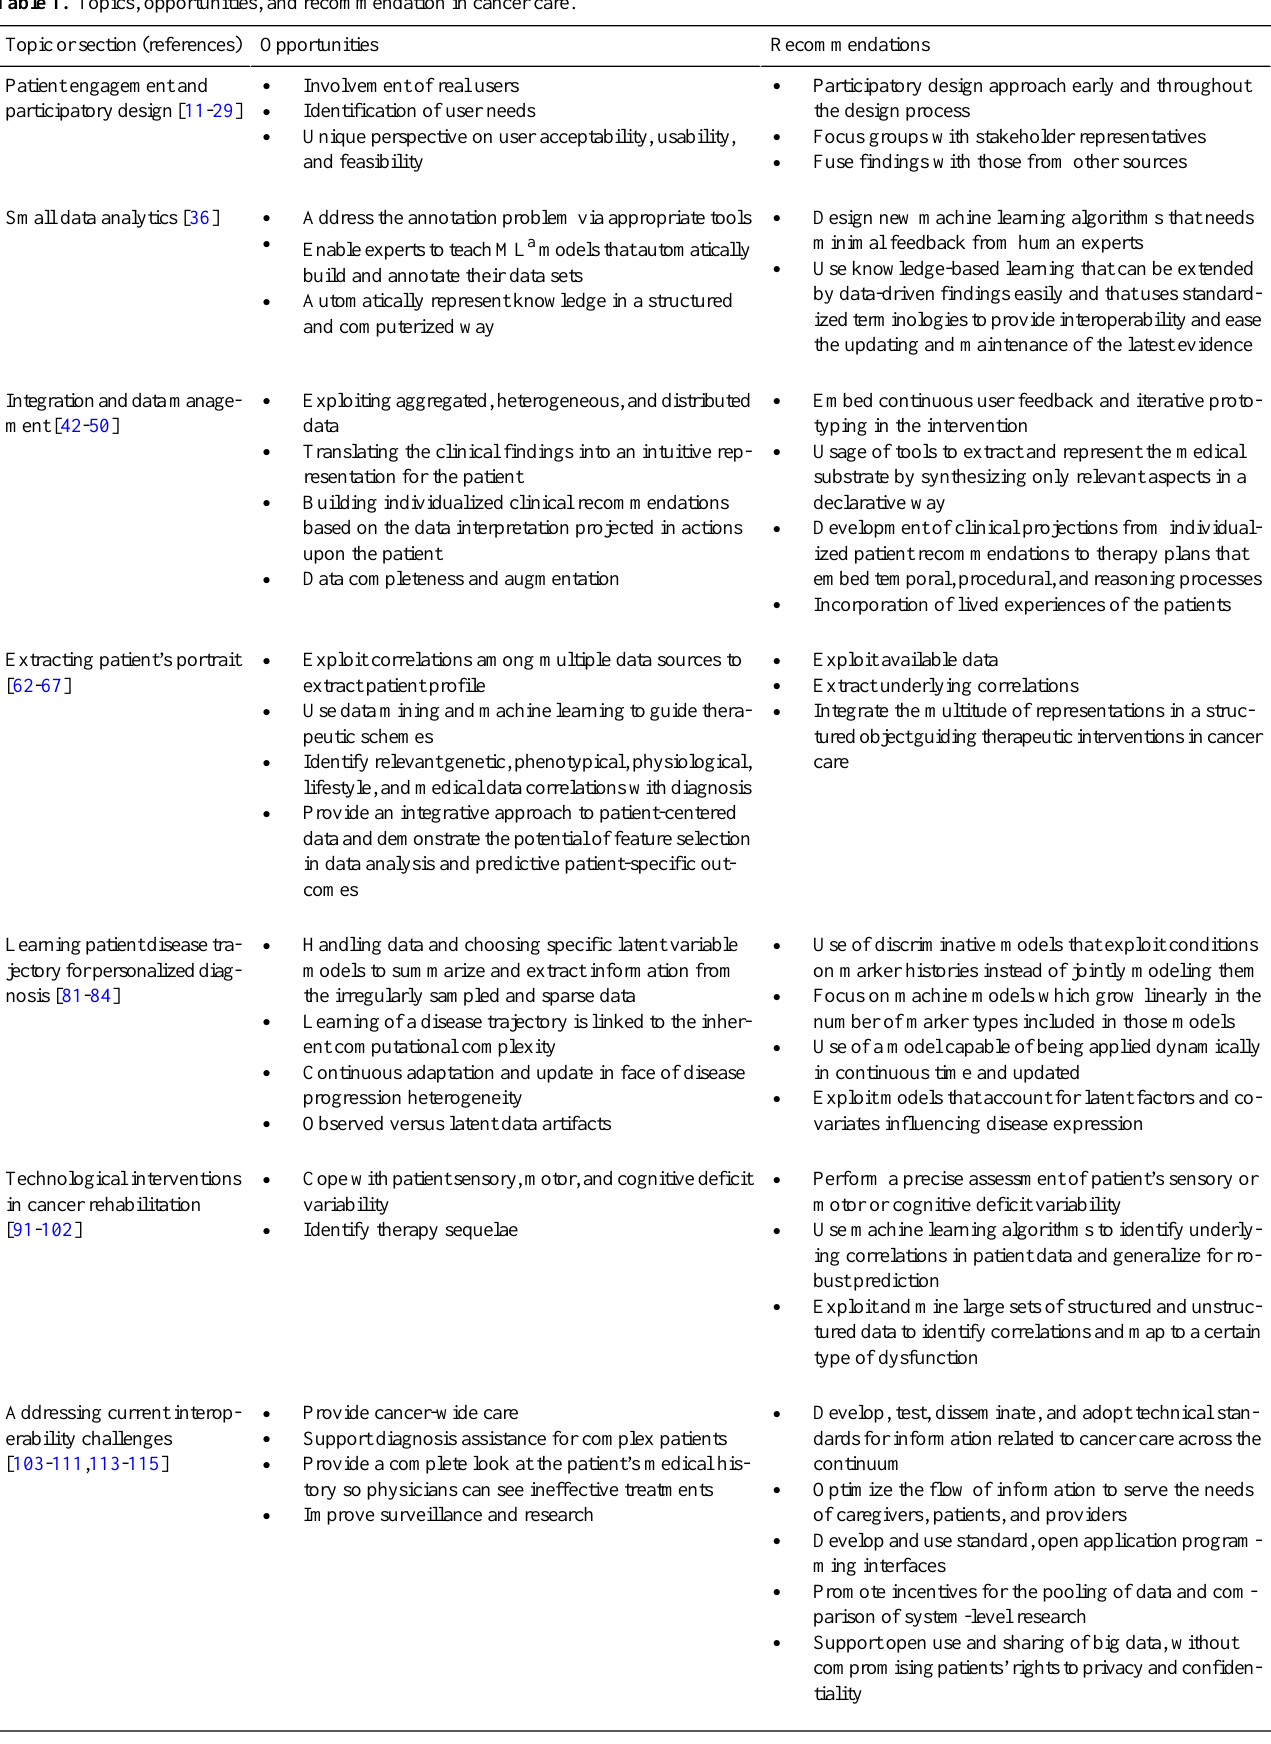
Table 1. Topics, opportunities, and recommendation in cancer